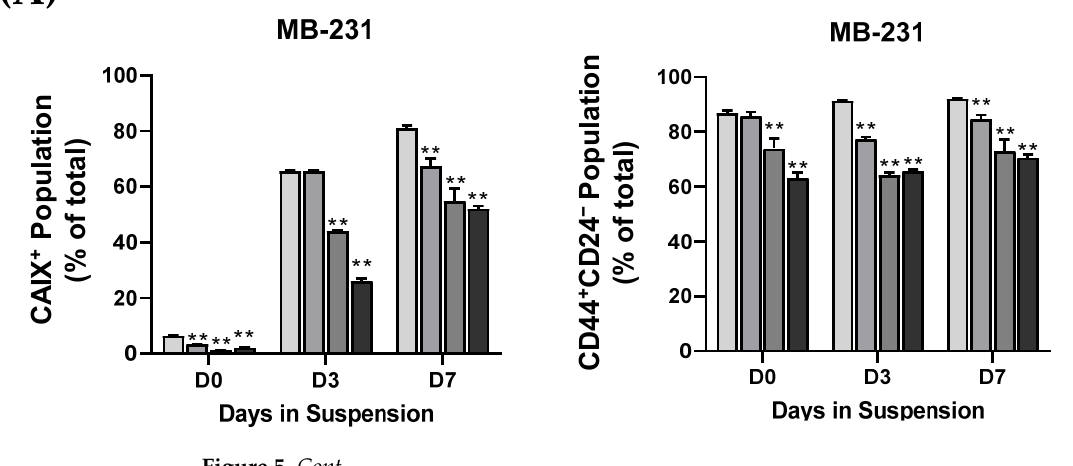
Figure 5. The cBCSC and CAIX populations are inhibited following treatment with U-104 under suspension. ( A ) MB-231 and ( B ) MCF7 cells were cultured in a monolayer (D0) or suspension condition for 3 or 7 days and then treated with 0, 10, 50, or 100 µ M of U-104 for 24 h. Treated cells were then analyzed for CD44, CD24, and CAIX surface expression using MIFC. The CAIX + and the CD44 + CD24 − decreased in a dose-dependent manner with U-104 treatment. (n = 3, * p < 0.05, ** p < 0.01). 4. Discussion Defining the molecular markers on CTC populations that span the molecular subtypes of breast cancer has the potential to improve breast cancer diagnosis and to identify novel therapeutic targets for treating metastatic cancers. However, this effort is often hindered by CTCs’ low frequency in blood, vast heterogeneity, poor survival, and analytical variability in isolating the cells. To address this, improved methods for CTC culture and expansion are necessary to facilitate comprehensive CTC studies. Several CTC models have been developed, including 2D cultures and CTC-derived explants (CDX models) using primary CTCs isolated from the blood of patients [35]. Here, we established an in vitro model of CTCs using non-adherent suspension cultures of BCC lines representing the molecular subtypes of TNBC, HER2 + , and ER + /PR + . In our design, individual BCC lines were cultured in suspension and under a monolayer, in parallel, thereby allowing for the pairwise analysis of CTCs and their counterparts in primary tumors. Overall, this CTC model was able to recapitulate several major molecular alterations in CTCs, as observed previously using primary CTCs from breast cancer patients [36–38]. In particular, the non-adherent suspension culture enriched CSC populations upon losing cell-matrix adhesion. Enriched CSCs were further shown to express higher levels of hypoxia-inducible genes—in particular, the hypoxia-inducible carbonic anhydrase IX (CAIX)—when compared to the monolayer